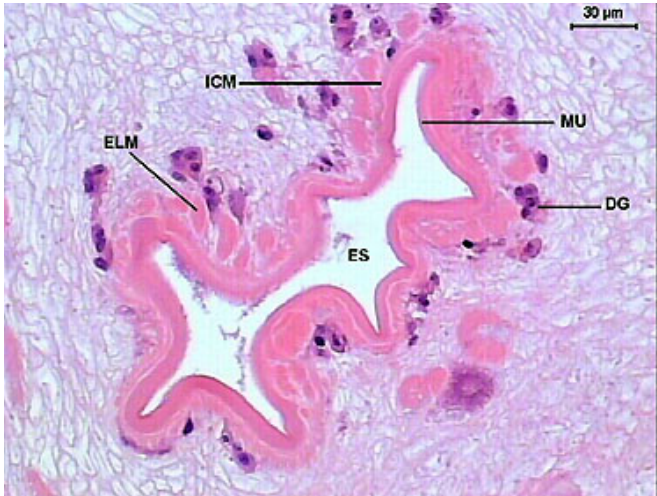
Figure 9. Transversal section of the final portion of Sticholecitha serpentis esophagus. ES – Esophagus, DG – digestive glands, MU – mucosa, ICM – internal circular musculature, ELM – external longitudinal musculature.